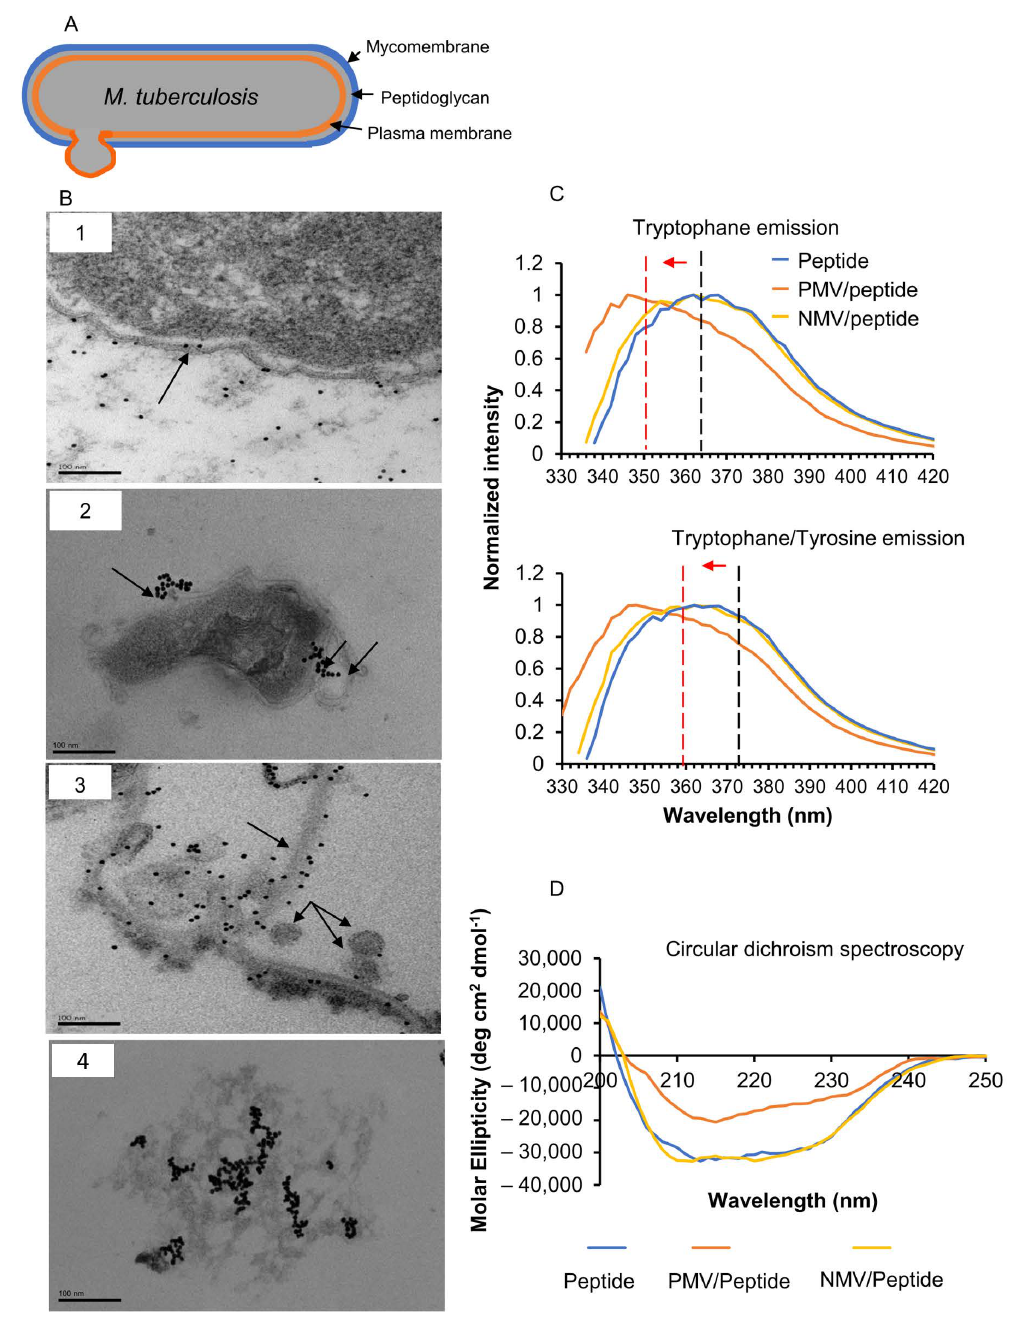
Figure 2. NZX characteristics upon binding. ( A ) Simplified model of the organization of the mycobac- terial envelope. ( B ) Transmission electron microscopy (TEM) showing the gold-labeled NZX that caused the membrane destabilization of M. tuberculosis (1–4). Scale bar: 100 nm. ( C ) Representative graph of intrinsic Trp + Tyr (upper panel) and Trp (lower panel) emission spectra of the peptide when interacting with the LUV at pH 7.4. In the presence and absence of vesicles, shifts in wavelength (arrow) and increased fluorescence intensity were recorded. ( D ) CD structure of NZX in the presence of vesicles. Peptide in PBS was used as the control. Secondary structure content was analyzed with the K2D3